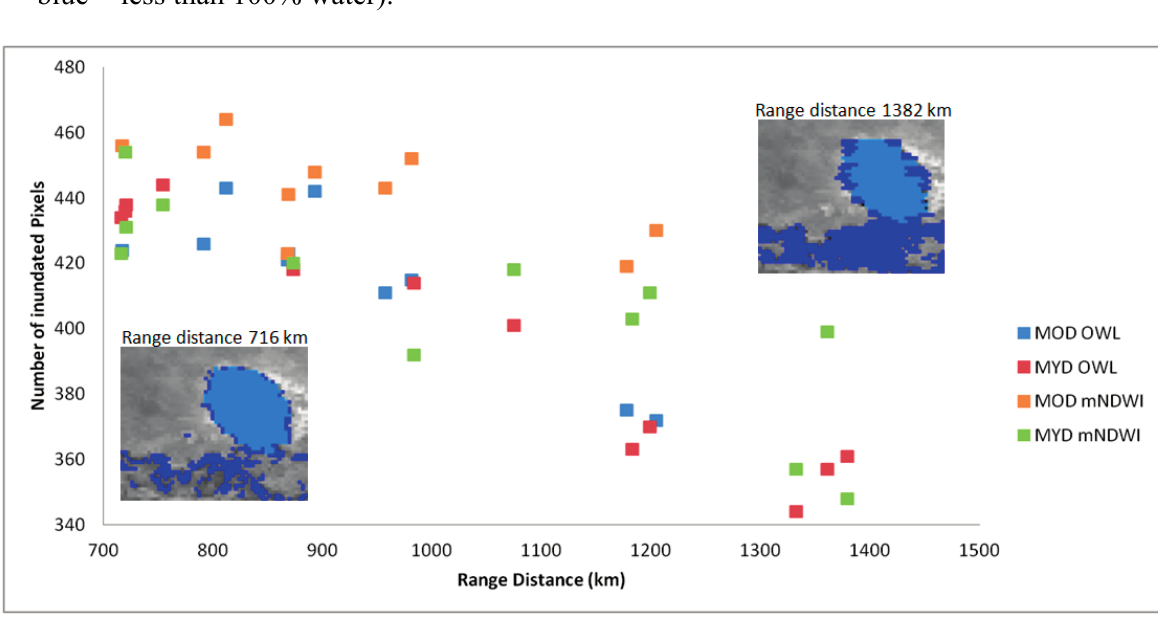
Figure 2. Relationship between MODIS range distance and number of inundated MOD and MYD OWL and mNDWI pixels for Lake Victoria for cloud-free images from 1st November until mid-December 2002. Two MODIS OWL images are shown as insets on the graph to further illustrate the influence of range distance (bright blue = pixels with 100% water, dark blue = less than 100%